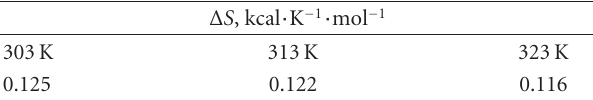
Table 6: The change in entropy ( Δ S ) for mild steel in 1M HCl in the presence of trans-4-hydroxy-4 (cid:2) -stilbazole inhibitor at various temperatures (303K–323